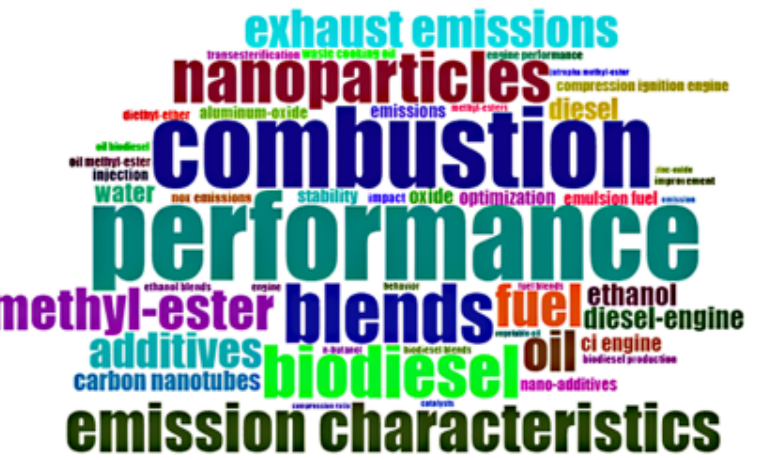
Figure 1. Top 50 keywords of research on nanoparticles as additives for biodiesel/vegetable oil/alcohol–diesel blends.